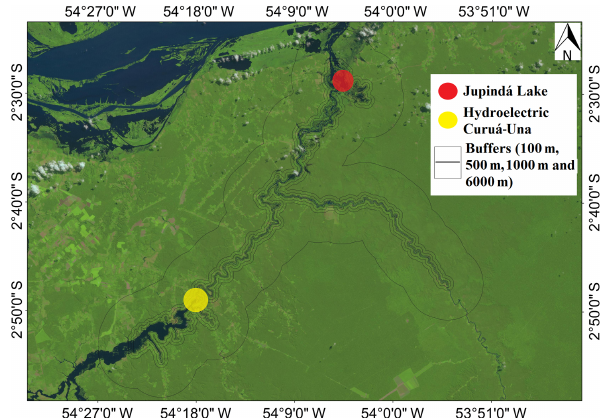
Figure 2. Different buffer sizes (100, 500, 1000 and 6000m) along the stretch of the Curuá-Una River from Jupindá Lake (red) to the hydroelectric dam upstream